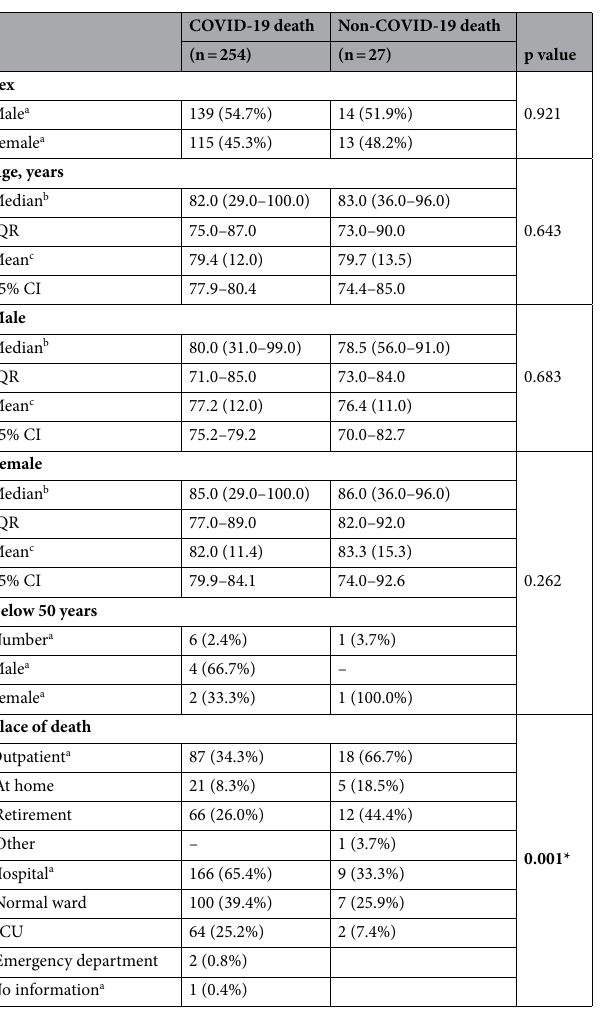
interval. a Number (%), b median (range), c mean (standard deviation). Statistically significant p values are highlighted in bold (*p < 0.05), the remaining values stayed